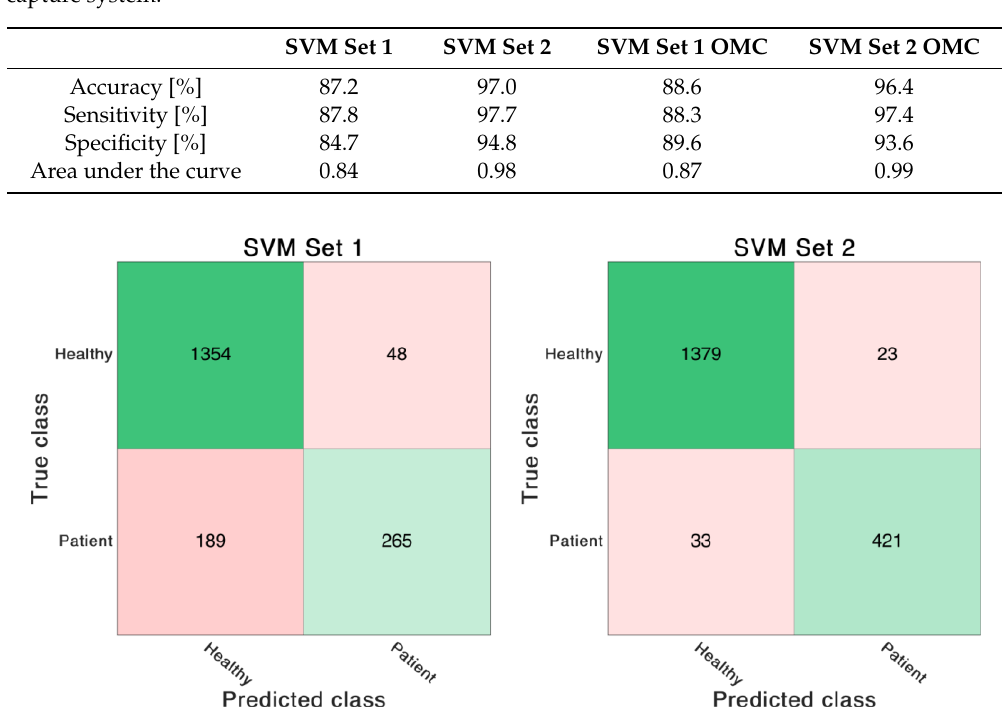
Figure 4. Confusion matrices of the SVM trained on IMU-based feature Set 1 and 2. The numbers in the matrices indicate correctly or incorrectly classified GC.